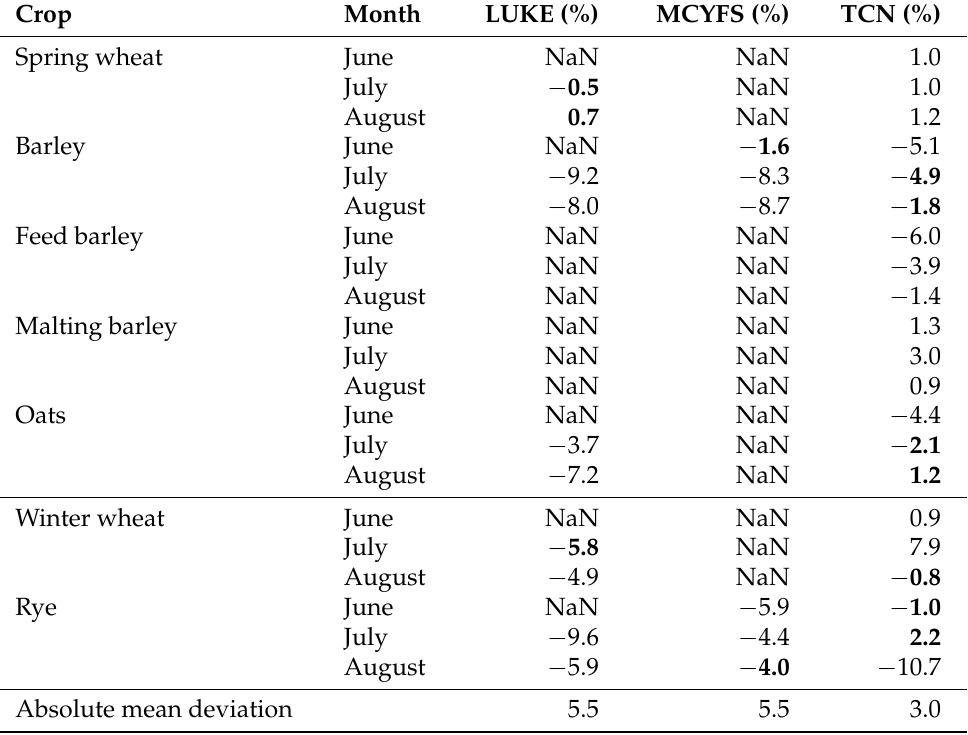
Figure 13. Bar plots of the mean farm-level predictions (TCN) and country-level published forecasts from JRC (MCYFS) and LUKE, in 2018–2020. The horizontal red line shows the 3-year mean of national level yields from the official crop statistics (LUKE). Black vertical lines show the minimum and maximum values of the three years. Note that the scale of the y-axis is zoomed to values between [2000, 5500]. Table 3. The deviation (%) of published country-level forecasts and TCN predictions from the actual crop yield. The lowest deviation (crop-wise) at the forecast time is printed in boldface. NaN means no forecast is